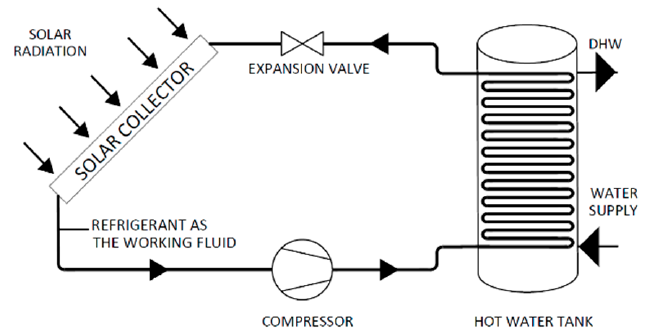
Figure 12. The schematic of the DX-SAHP system.